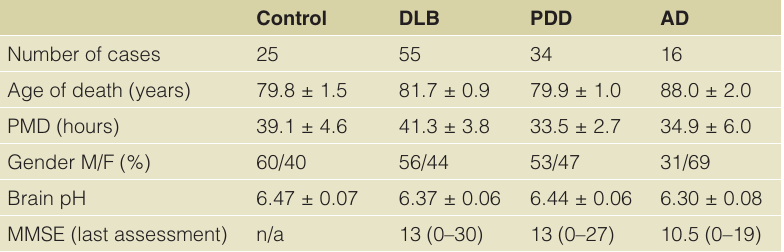
Table 1. Summary of subject demographics. Values are mean ± SEM. DLB: Dementia with Lewy Body; PDD: Parkinson’s Disease Dementia; AD: Alzheimer’s Disease. PMD: